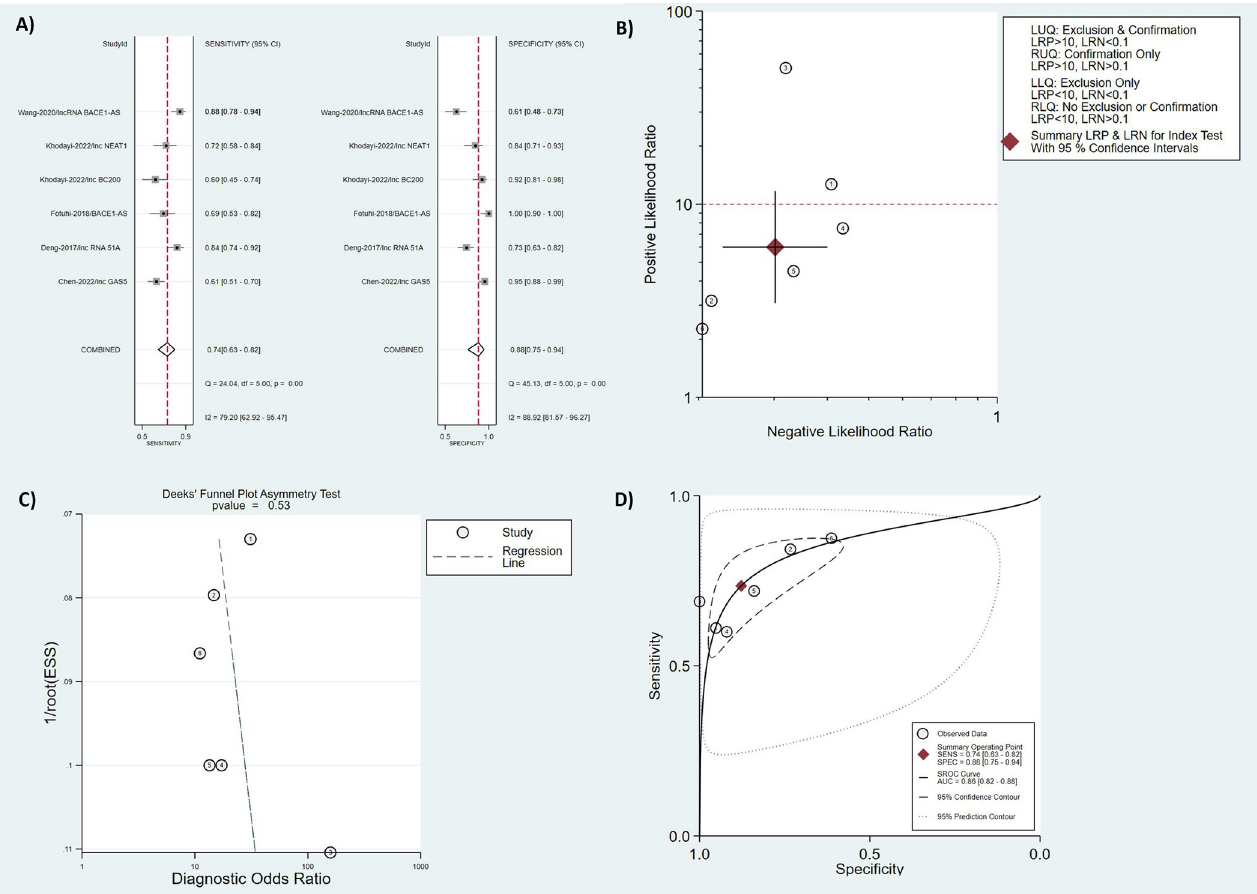
Fig 2. Meta-analysis of diagnostic accuracy of lncRNAs in AD patients vs. HCs (sensitivity and specificity). A: Forest Plot. B: Summary of Positive and Negative Likelihood Ratio. C: Funnel Plot. D: SROC Curve.